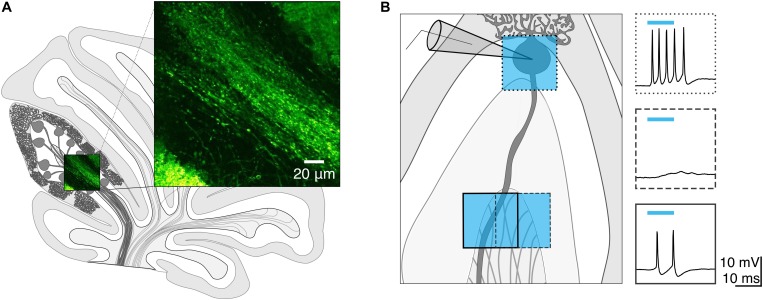
Channelrhodopsin-2 expression in Purkinje cell axons. (A) Schematic of sagittal cerebellar slice. Inset is a maximal intensity projection of a two-photon stack showing ChR2(H134R)-EYFP expression (green) in axons in the white matter. (B) Left, schematic showing multiple photostimulation regions (blue squares) and somatic recording electrode. Right, representative current-clamp traces show optically evoked action potentials following somatic (box with dotted line outline) and white matter (dashed and solid line outline on boxes) stimulation locations. Shifting the photostimulation location ∼30 μm in the white matter of the cerebellum produced action potentials. Blue bars above traces indicate onset and duration of light pulse.